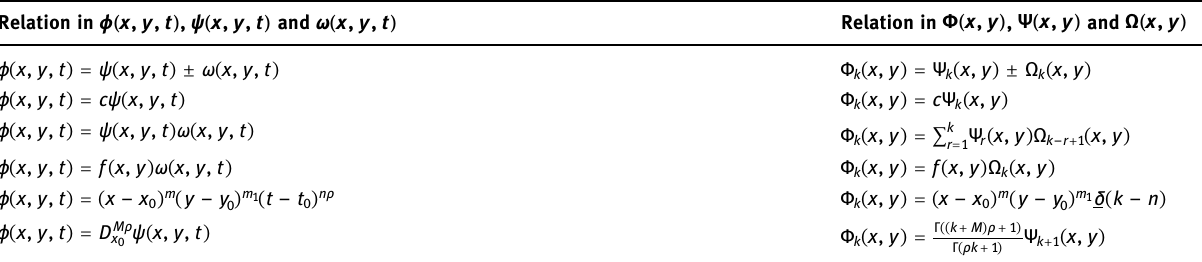
Table 1: Table of di ff erential transforms Relation in ϕ x y t , ,